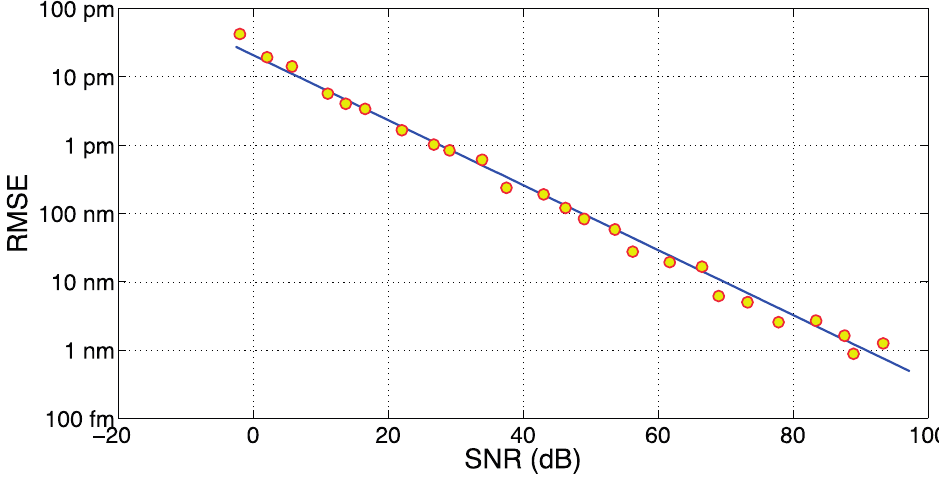
Figure 7. RMSE on FBG wavelength detection, using the KLT-based tracking algorithm, as a function of the SNR; simulation data (dots) and linear fit (line) are